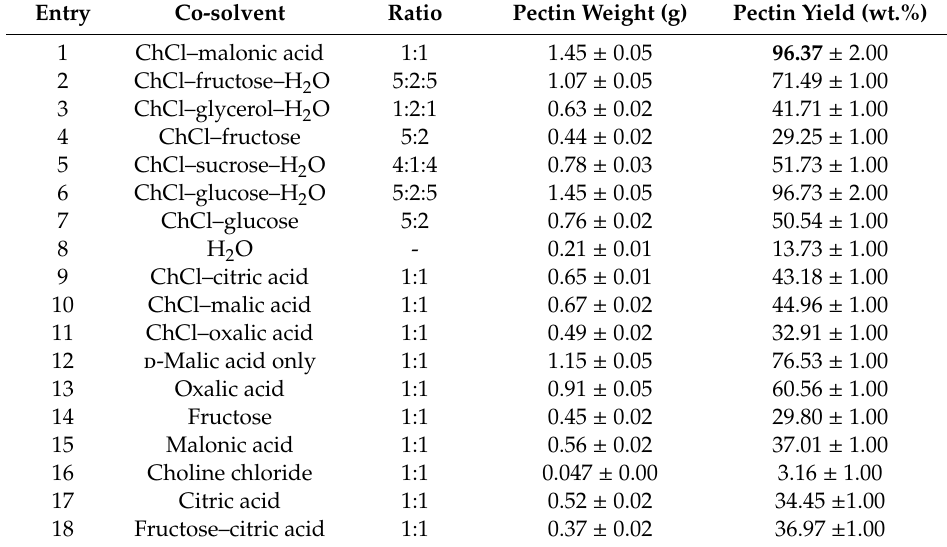
Table 2. Percentage of pectin yield per gram of powder used in several NADESs and raw components compared with